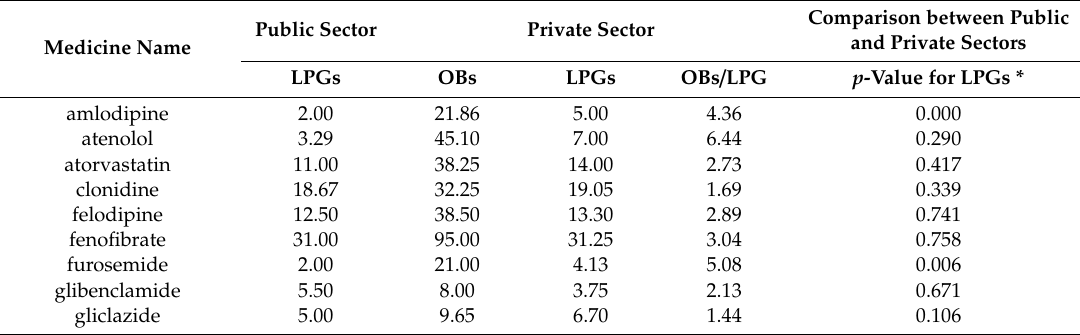
Table 2. Comparison of LPGs’ median unit price (in PHP; Philippine peso) between public and private sectors.